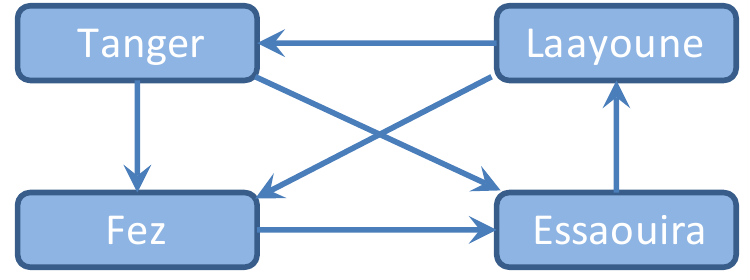
Figure 4. Four alternatives with cyclic pairwise winning indices.